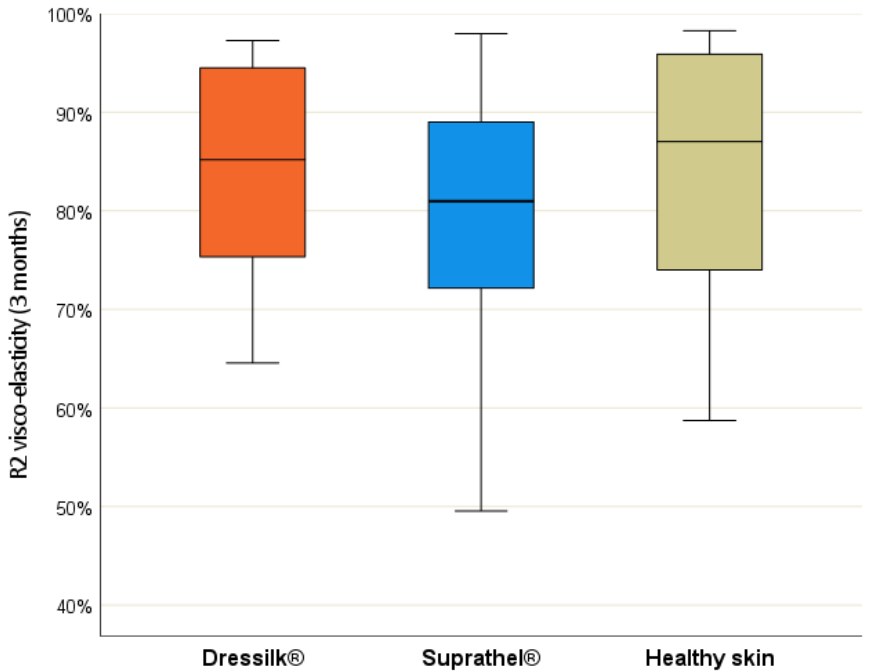
Figure 3. R 2 -values (visco-elasticity) after 3 months of areas treated initially with Suprathel (blue), Dressilk(orange) and the uninjured control area (green).